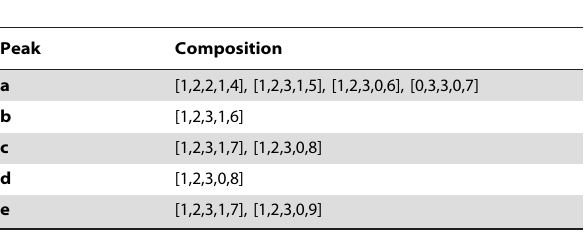
Table 2. Composition profiling of the peaks from SAX separation with most abundance changes after HSulf2